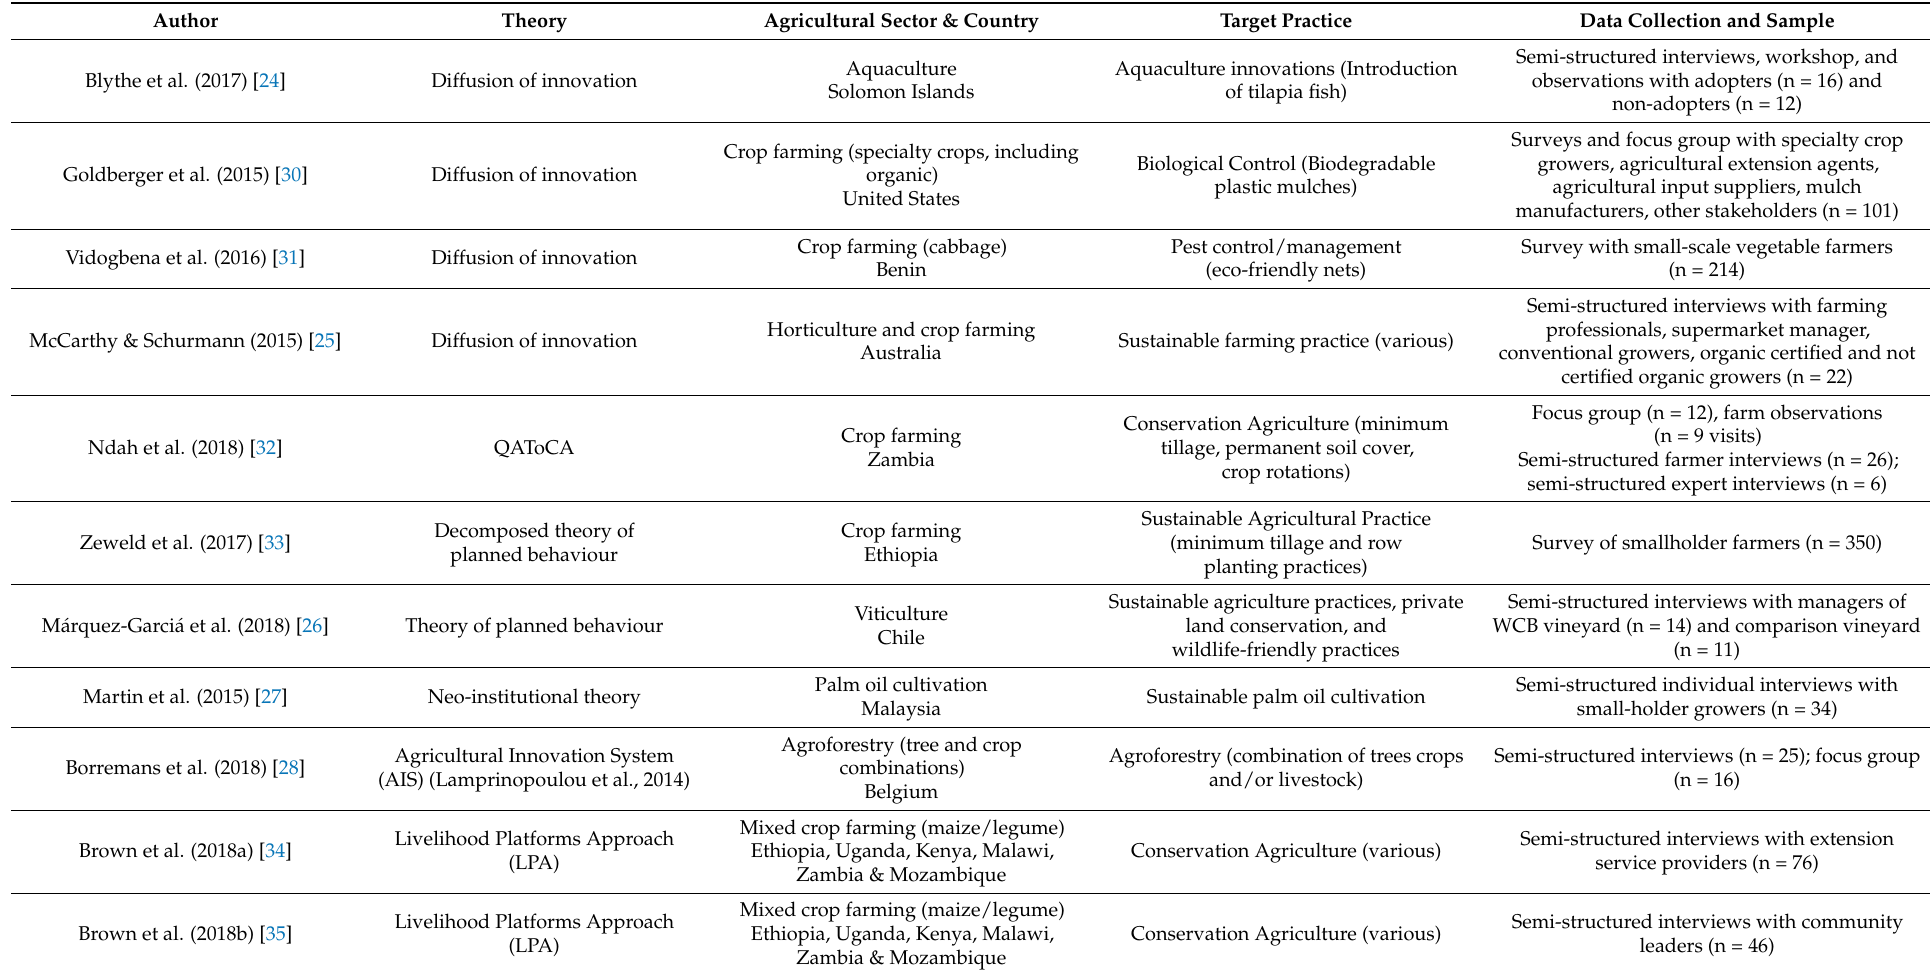
Table 1. Description of